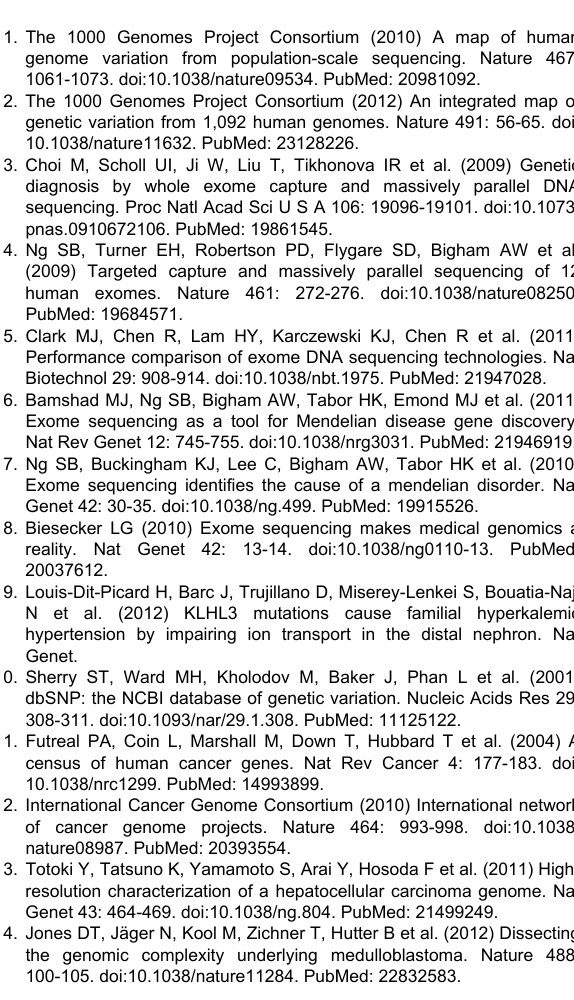
Table S1. The comparison of our dataset with the other different study. We provided the comparison of our dataset with the genes identified in the other different study with transcriptome and epigenome data in lung cancers.